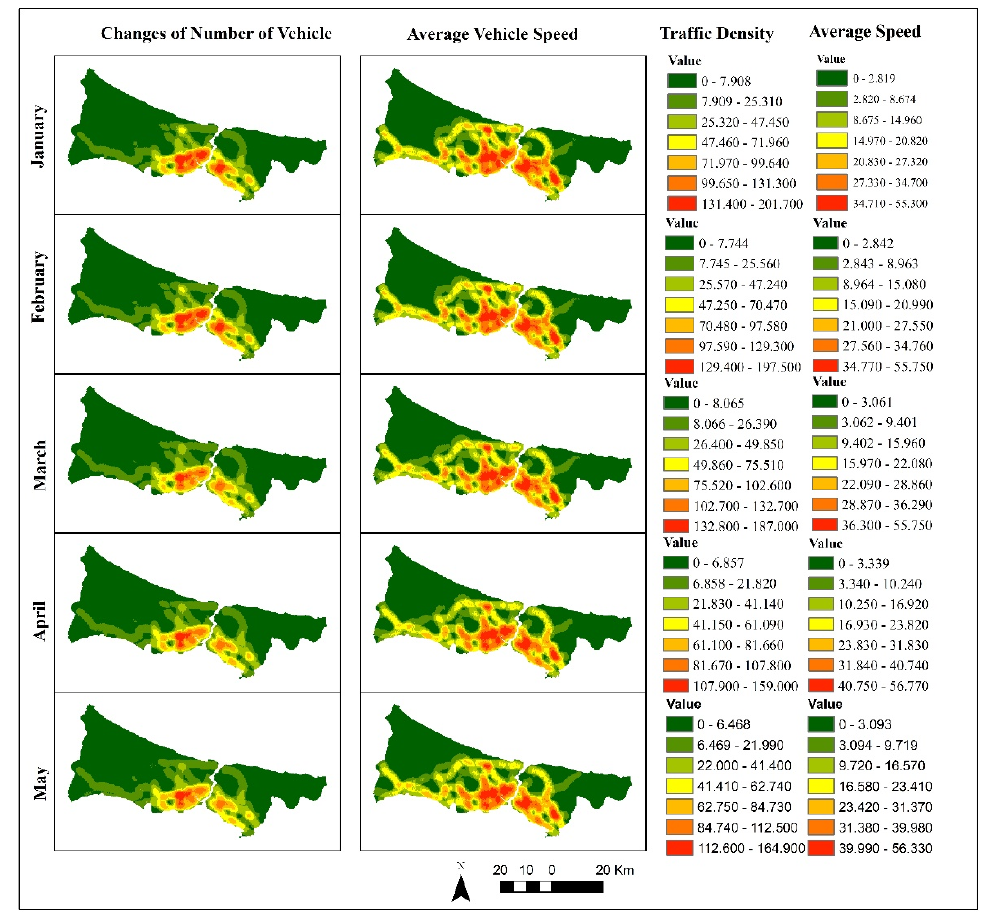
Figure 3. The maps of number of vehicles and vehicle speed’s changes.